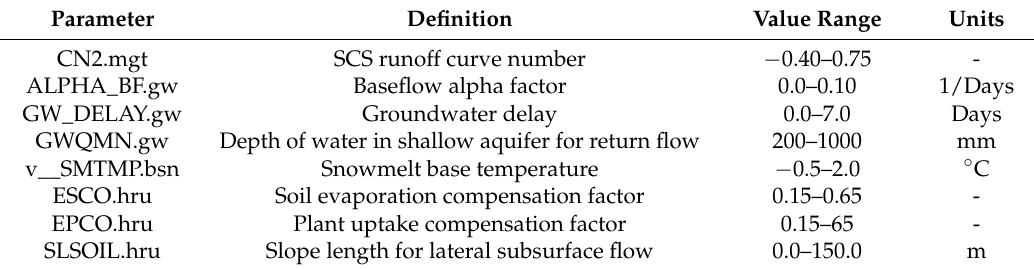
Table 1. Range of values for the most sensitive parameters in SWAT streamflow calibration using SWAT-CUP. The parameter is listed by name and SWAT input file type, definition and the range of values that were selected for the model.